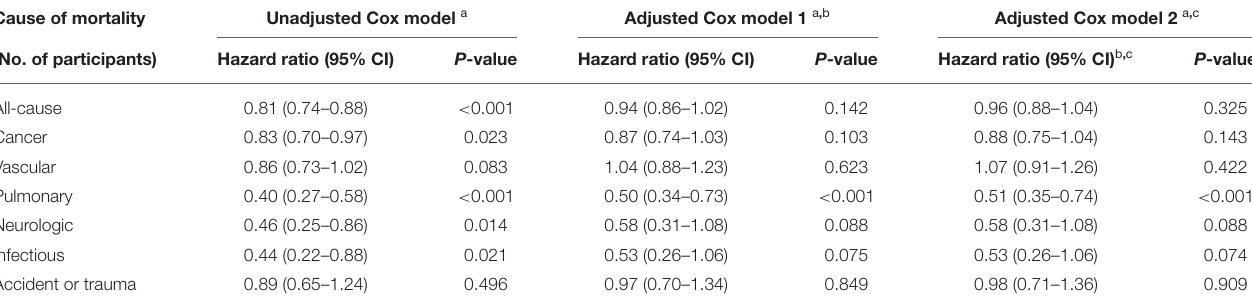
TABLE 2 | Hazard ratios for all-cause and cause-specific mortality in elderly patients with vitreoretinal disease stratified by vitrectomy status. Cause of mortality